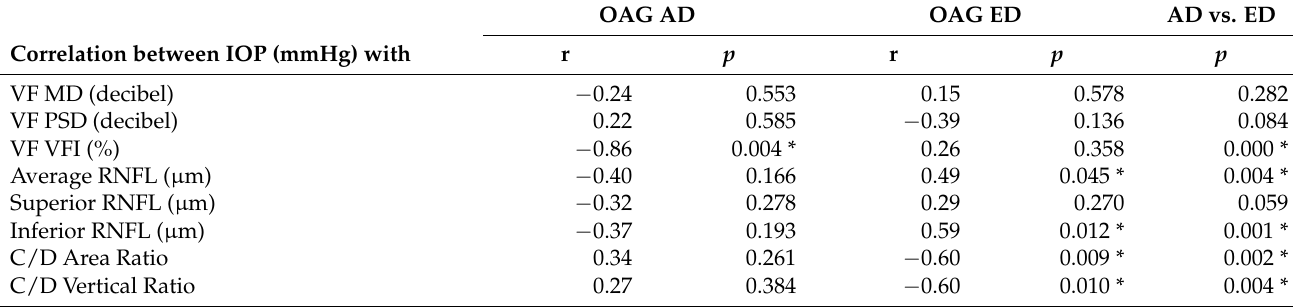
Table 4. Spearman correlations (r) between intraocular pressure (IOP) and functional, structural